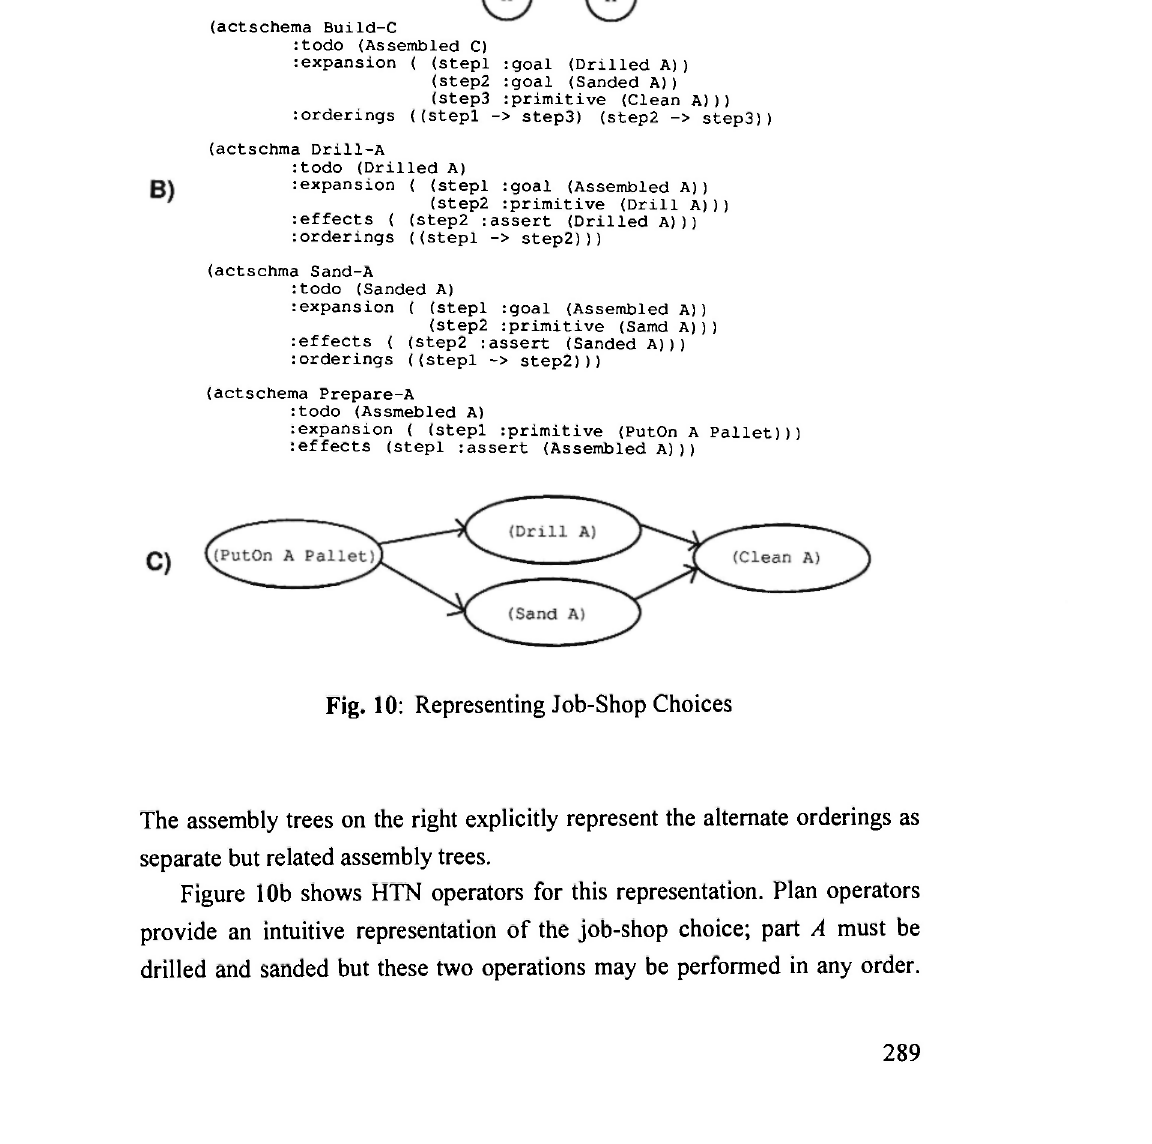
Fig. 10: Representing Job-Shop Choices